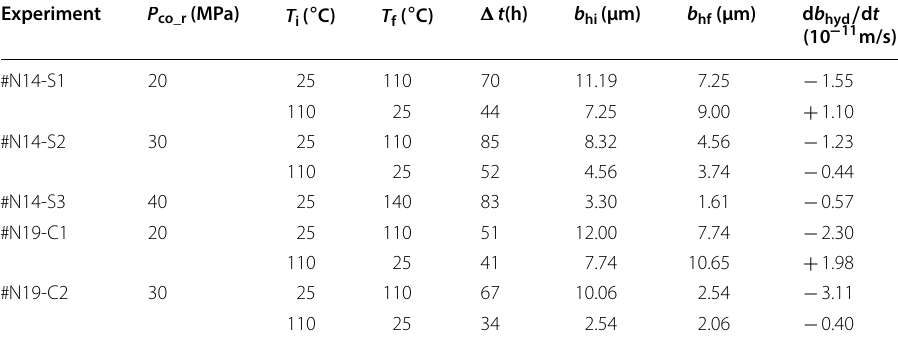
Hydraulic measurements of hydraulic aperture ( b hyd ), where T i and T f are the temperatures at the beginning and at the end of the respective cycle, (cid:31) t is the duration of the cycle, b hi and b hf are the hydraulic apertures at the beginning and at the end of the respective cycle, and P co_r is the radial confining pressure